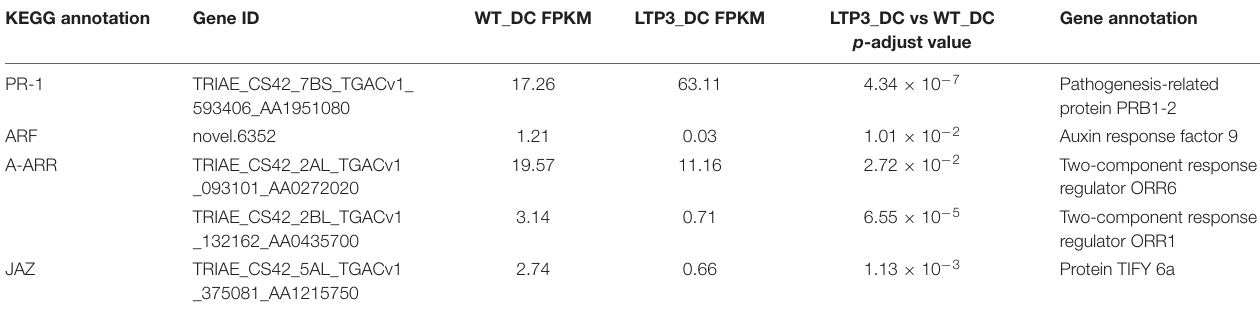
TABLE 1 | DEGs of “LTP3_DC vs. WT_DC” annotated in the KEGG pathway of “plant–pathogen interaction” and “plant hormone signal transduction.”